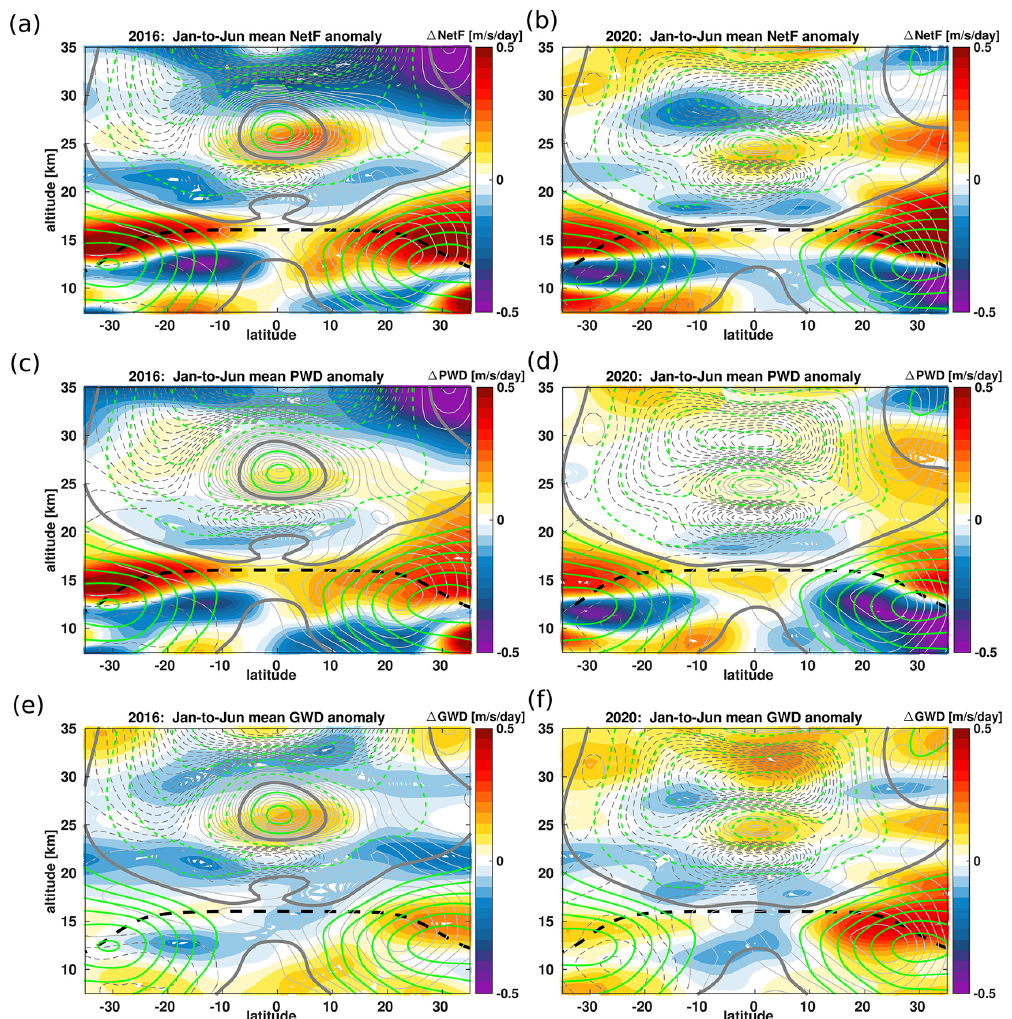
Figure 6. January–June 2016 (a, c, e) and 2020 (b, d, f) deviations from the January–June 1979–2014 average of monthly mean, zonal mean net wave forcing (NetF) (a, b) , planetary wave drag (PWD) (c, d) , and gravity wave drag (GWD) (e, f) from the ERA5 reanalysis (filled contours) together with the January–June 2016 and 2020 zonal mean zonal wind (green contour lines) as a function of latitude and altitude. The black dashed horizontal line indicates the tropopause from the ERA5 reanalysis. The January–June 2016 and 2020 monthly mean, zonal mean wind anomaly component, U (ms − 1 ), from the ERA5 reanalysis is overlaid as solid grey contours (westerly) and dashed grey contours